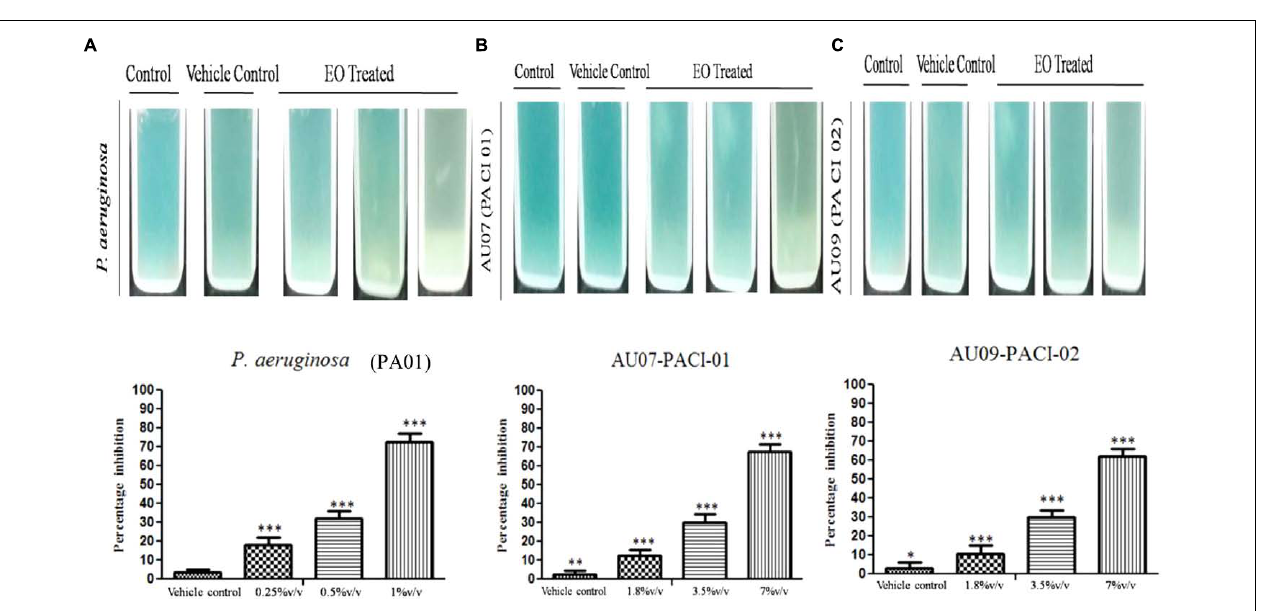
Frontiers in Microbiology |